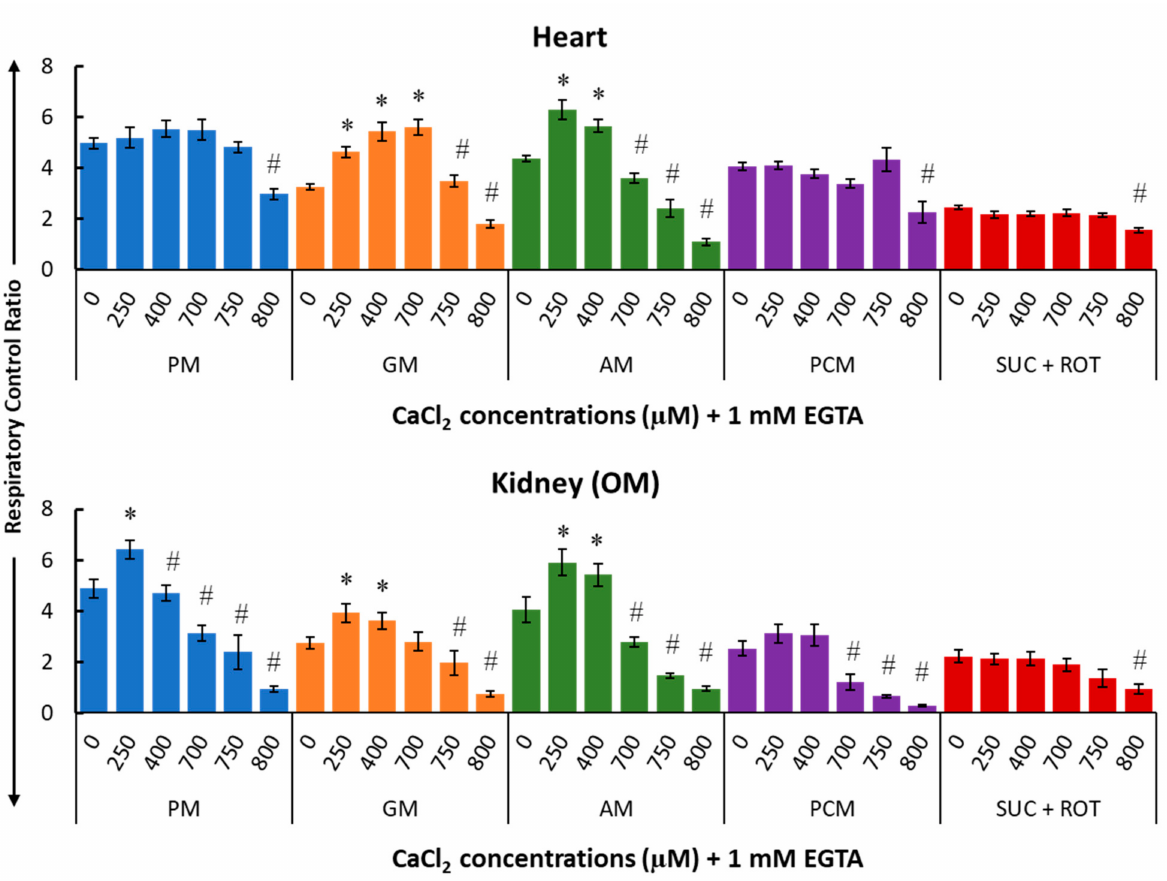
Figure 6. Summary of the different respiratory substrate-dependent effects of Ca 2+ on the respiratory control ratio (RCR; state 3/state 2 OCR) for the heart (upper panel) and kidney OM (lower panel) mi- tochondria. The X-axis shows CaCl 2 added to the buffer in the presence of 1 mM Ca 2+ chelator EGTA. Each bar plot represents the mean value ± SEM ( n = 4–6) of RCR. The symbol ‘*’ denotes significantly higher results than the baseline RCR ( p < 0.05), while the symbol ‘#’ denotes significantly lower results than the peak RCR ( p < 0.05); both are based on one-way ANOVA with repeated